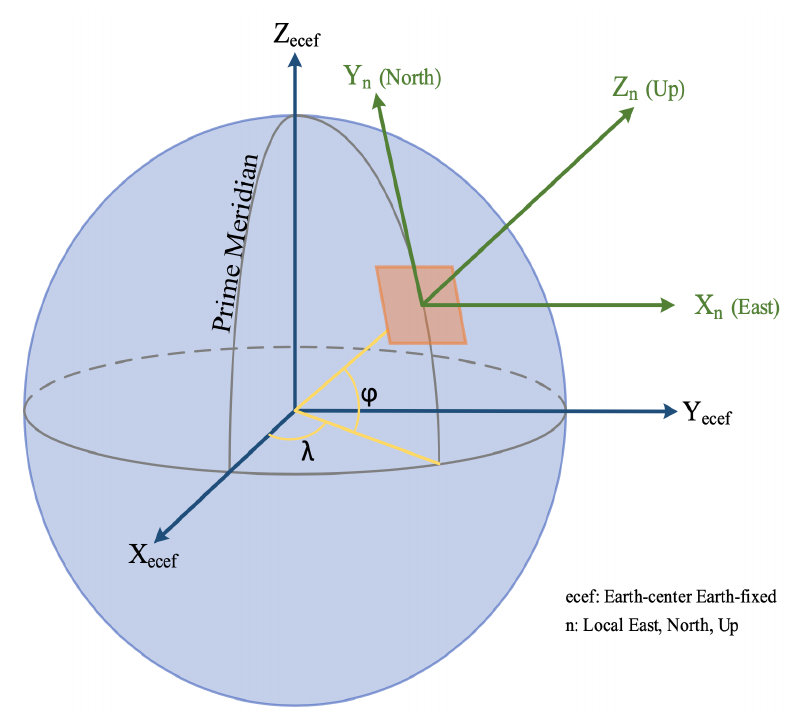
Figure 4. Geodetic, ECEF, and local ENU coordinate